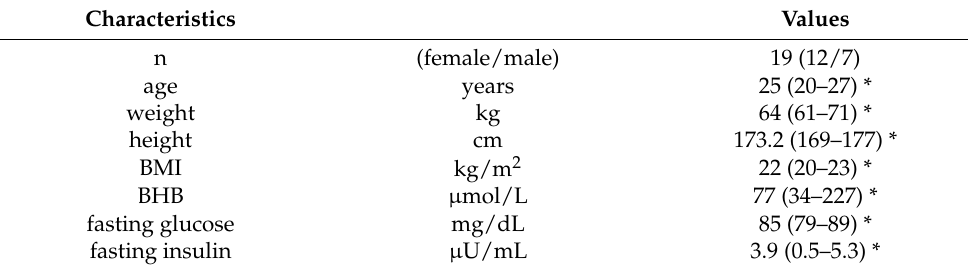
Table 1. Baseline demographic and biochemical variables of the